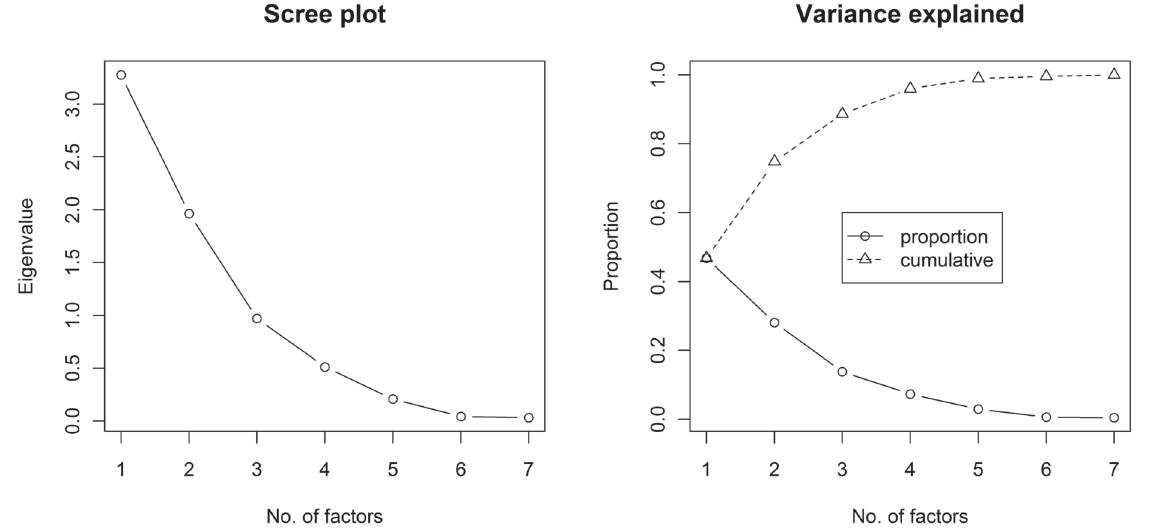
Fig. 2. Scree plot and variance explained for factor selection under